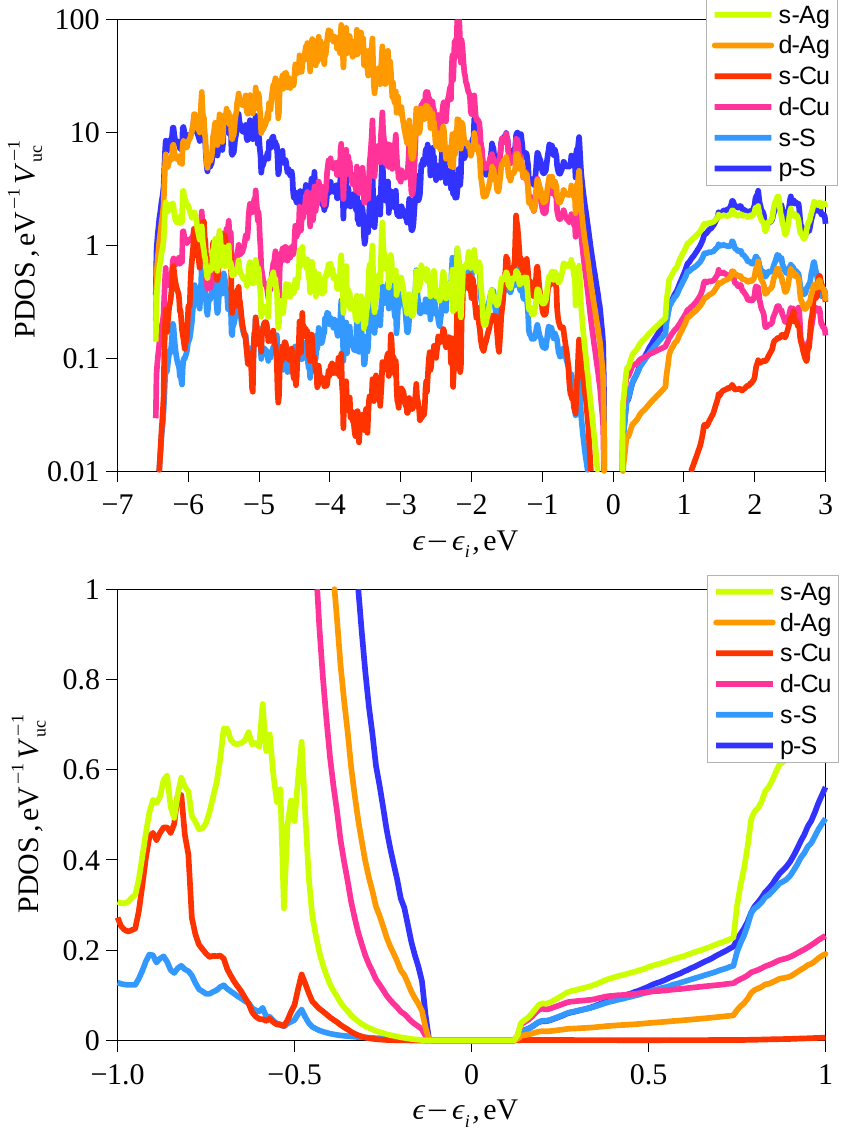
Figure 9. Atomic state projected density of electron states (PDOS) in Ag 3 CuS 2 (I4 1 /amd). Upper panel shows PDOS in logarithmic scale in the wide energy range, while lower panel shows PDOS around the band gap. Energy is counted from the middle of the band gap (cid:101) i